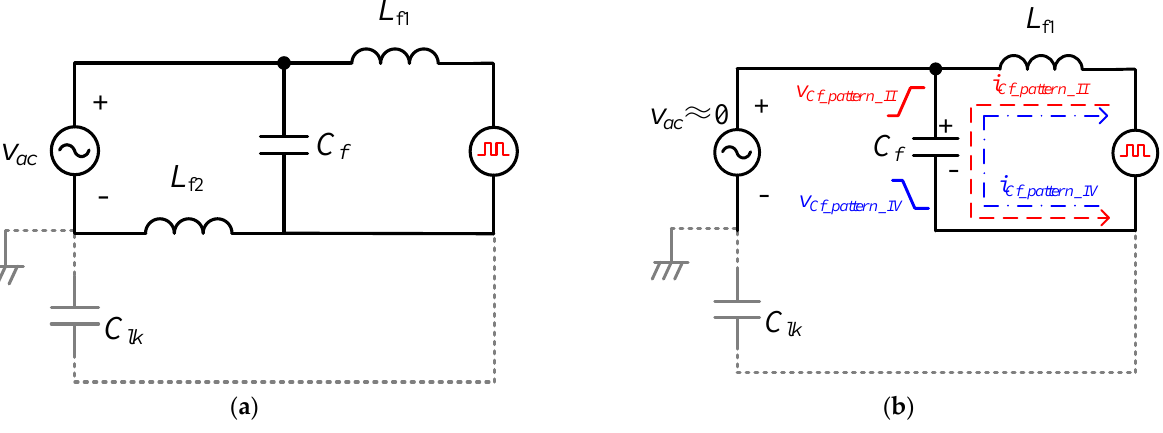
Figure 5. Equivalent circuit of every pattern. ( a ) Pattern I and Pattern III, ( b ) Pattern II and Pattern IV.